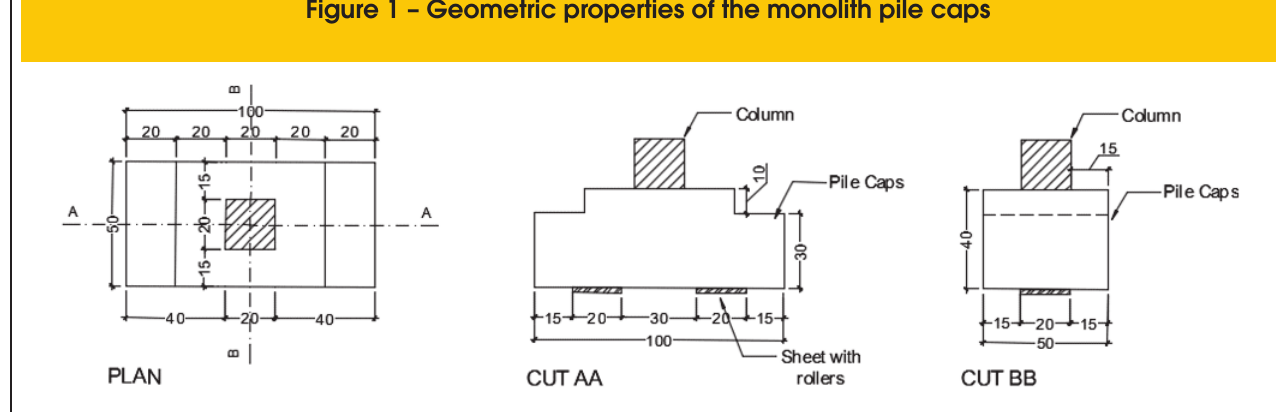
Figure 1 – Geometric properties of the monolith pile